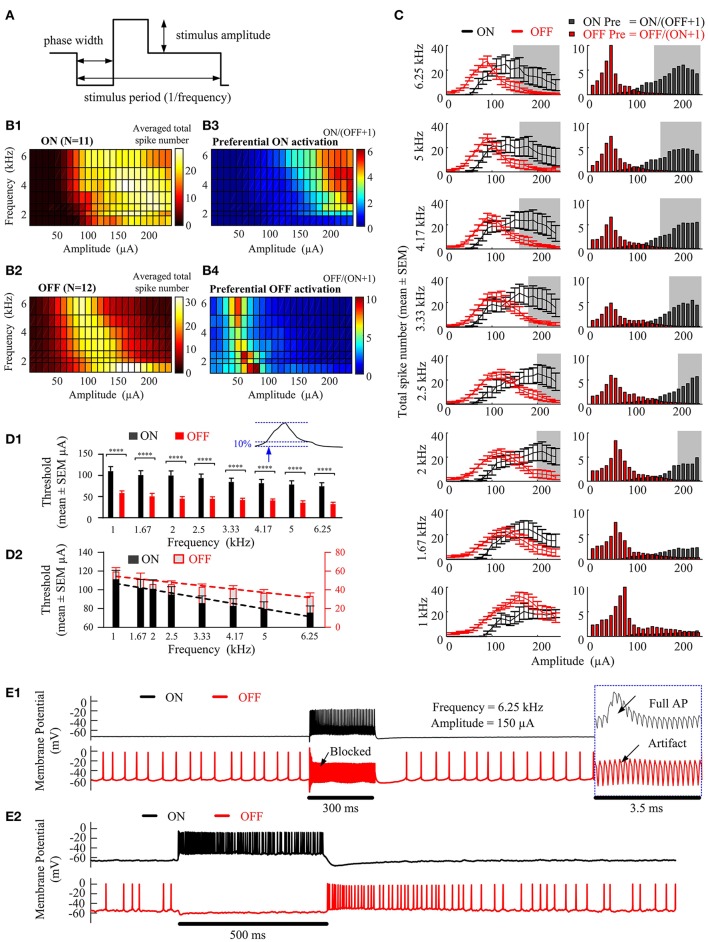
Preferential RGC activation as a function of stimulation amplitude and frequency. (A) High-frequency electrical stimulation waveform. Cathodic-first, charge-balanced, biphasic stimuli with pulse width of 40 μs per phase were used. The stimulus period was determined by the pulse repetition frequency. All pulse trains were 300 ms in duration. (B1,B2) Activation maps showing the averaged total spike number elicited in ON (N = 11) and OFF (N = 12) RGCs in response to a range of stimulation amplitudes (10~240-μA) and frequencies (1~6.25-kHz). All RGCs were identified using a stationary spot of light. (B3,B4) Preferential RGC excitability map is defined as the ratio of the averaged total spike numbers of ON RGCs over that of the OFF RGCs. (C) Left column, juxtaposition of the averaged ON and OFF spike count against stimulating amplitude, at frequencies 6.25, 5.0, 4.17, 3.33, 2.5, 2.0, 1.67, and 1.0 kHz. The error bars indicate standard error of the mean. Right column, Stimulus-dependent preferential ON and OFF activation at each stimulation frequency, indicated by the ratio of averaged total spike numbers of ON over that of the OFF cells. The shaded region shows the optimal stimulation settings for which the overall mean spike number of the ON cell population is three times that of the OFF cell population. i.e., σON(Ai, Fi) ≥ 3 σOFF(Ai, Fi). (D1) Stimulation thresholds (defined by the stimulation amplitude able to elicit 10% of the maximum spike number of each non-monotonic spike-stimulus profile) for ON and OFF RGC populations. The ON cell population had a generally higher threshold across all stimulation frequencies than the OFF cell population (repeated measure 2-way ANOVA followed by multiple comparisons with Bonferroni correction, ****p < 0.0001). (D2) Linear regression lines fitted to stimulation thresholds against stimulation frequencies for ON and OFF populations. The negative values of the slopes of linear regression lines (−0.0067 ± 0.00076 for ON RGC population, and −0.0043 ± 0.00062 for OFF RGC population) indicated a trend of decreasing threshold with increasing frequency (p < 0.05). Different scales were used for ON (black) and OFF (red) RGC populations. (E1) Examples of RGC responses from the ON and OFF RGC populations in (B). With 6.25 kHz stimuli of 150 μA, the ON RGC was strongly activated, while simultaneously blocking the OFF RGC's spontaneous spikes, yielding only stimulus artifacts. Insert: expanded view of the traces. (E2) Examples of ON and OFF RGC responses following light stimulation. The HFS-induced neuromodulation in (E1) elicits preferential excitation of ON and OFF RGCs in a manner similar to RGC responses to light stimuli in the healthy retina (E2).